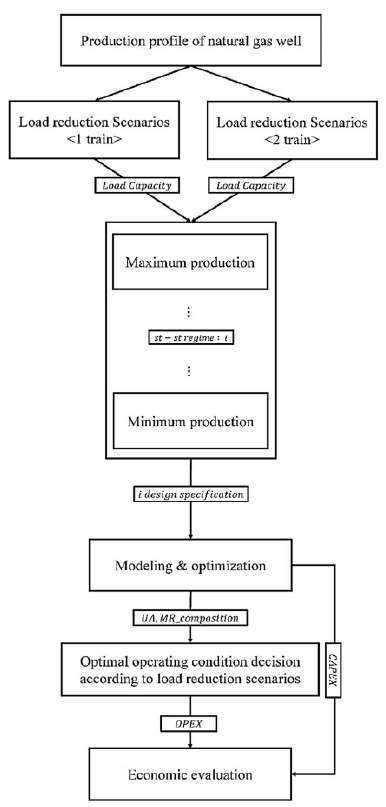
Figure 33. An optimization framework for the proposed design approach [113]. Reproduced with permission from Elsevier (license number